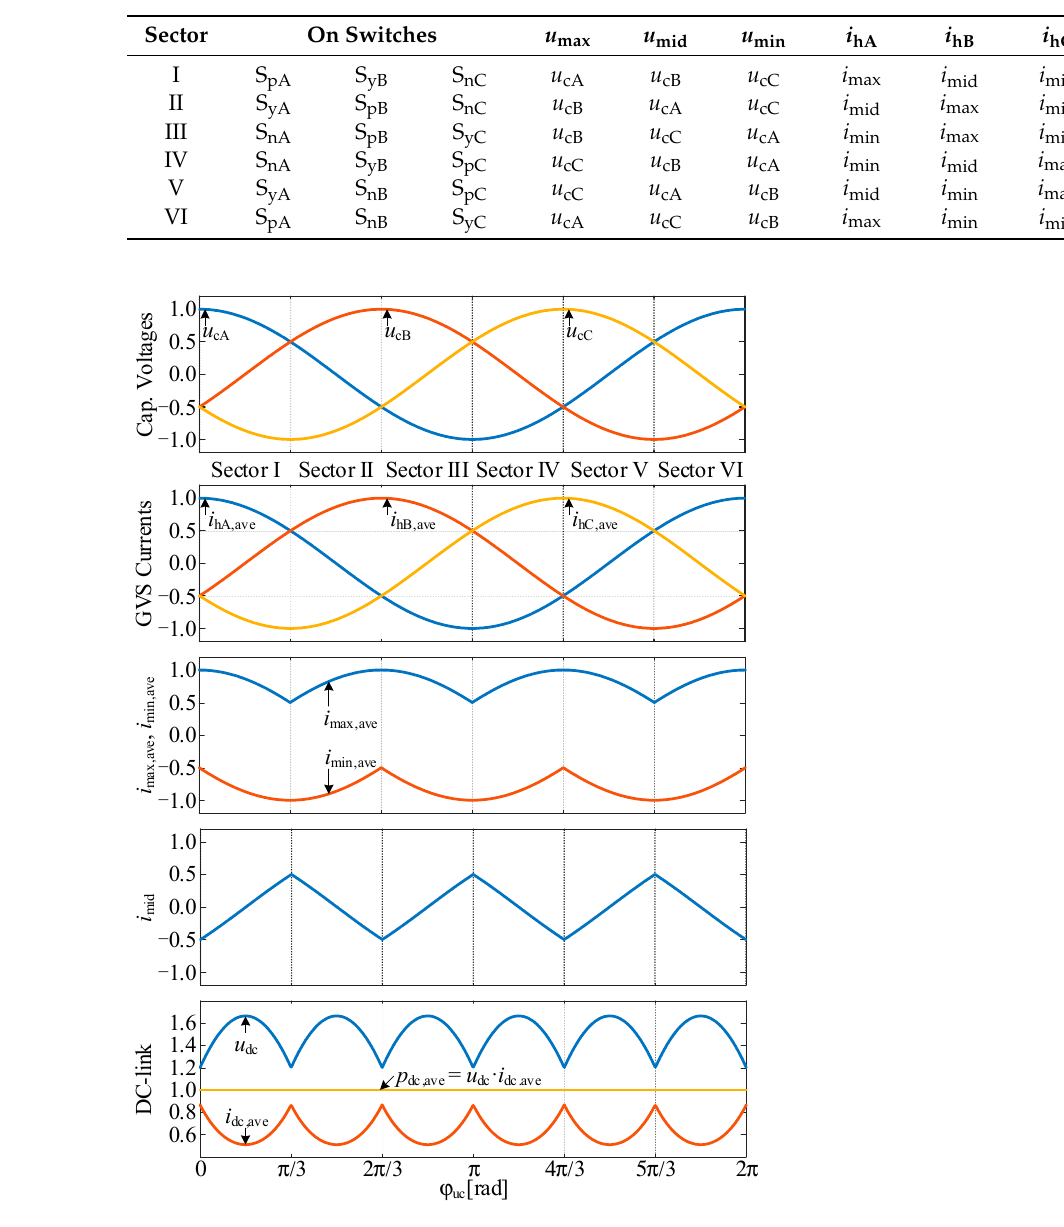
Table 1. Switching states of the GVS.